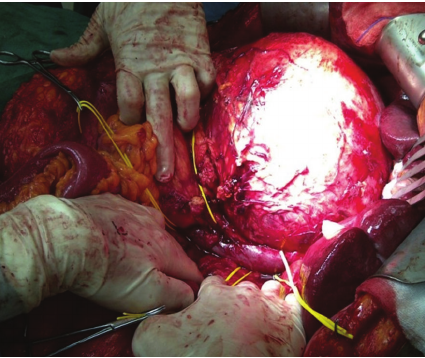
Figure 1: Coronal plane of patients preoperative MRI scan, demon- strating the right quadrant huge mass.